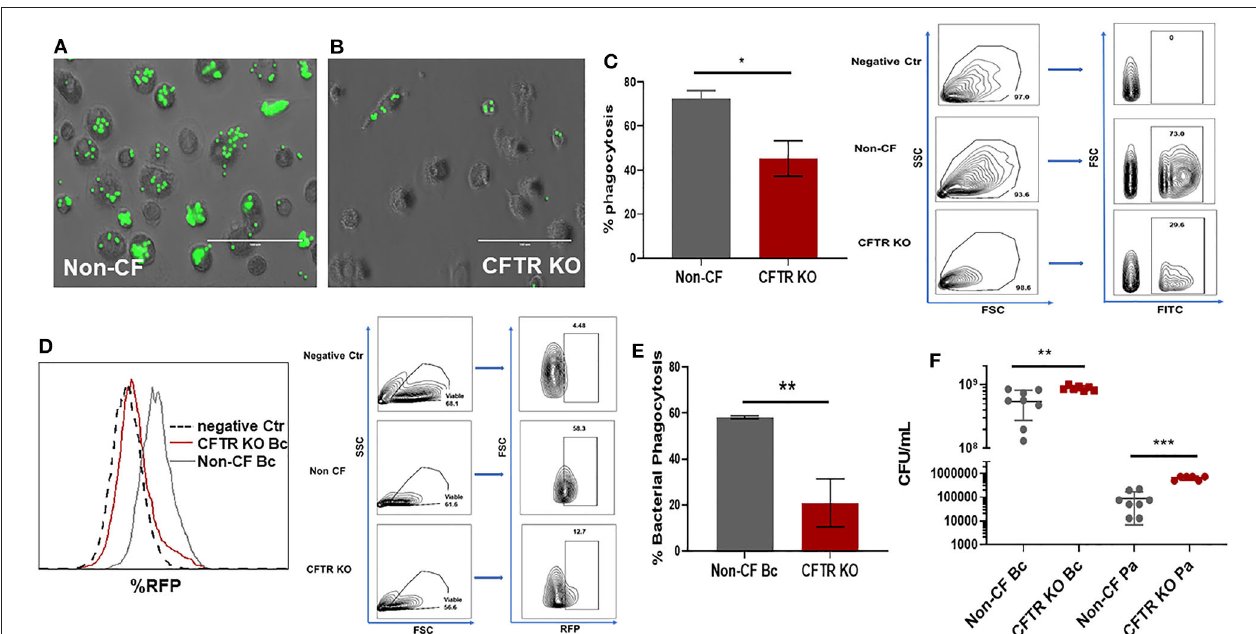
FIGURE 4 | CFTR KO reduces bacterial phagocytosis and killing. Phagocytosis of FITC-labeled beads for (A) non-CF and (B) CFTR KO MDMs, 100 µ m scale bar. Non-phagocytosed beads are washed away before imaging. (C) Summed % phagocytosis and representative FACS gating strategy for (A,B) , n = 3 donors, mean ± SD. Gating on FSC, SSC, and FITC. Phagocytosis shown as percent of cells with internalized beads. (D) Representative flow cytometry histogram and FACS gating strategy for bacterial phagocytosis assay for non-CF and CFTR KO MDMs. Histogram with overlay difference in uptake of RFP-labeled B. cenocepacia (Bc). The dashed black line (negative Ctr) were non-CF MDMs without infection. FACS gating on FSC, SSC, and RFP. (E) Summed %phagocytosis of RFP-expressing B. cenocepacia , n = 3/group, MOI 50, mean ± SD. (F) CFU assay in non-CF and CFTR KO MDMs infected with B. cenocepacia (Bc) or P. aeruginosa (Pa), log scale, n = 6–8 donors, mean ± SD. * p < 0.05, ** p < 0.01,*** p < 0.001, via unpaired t